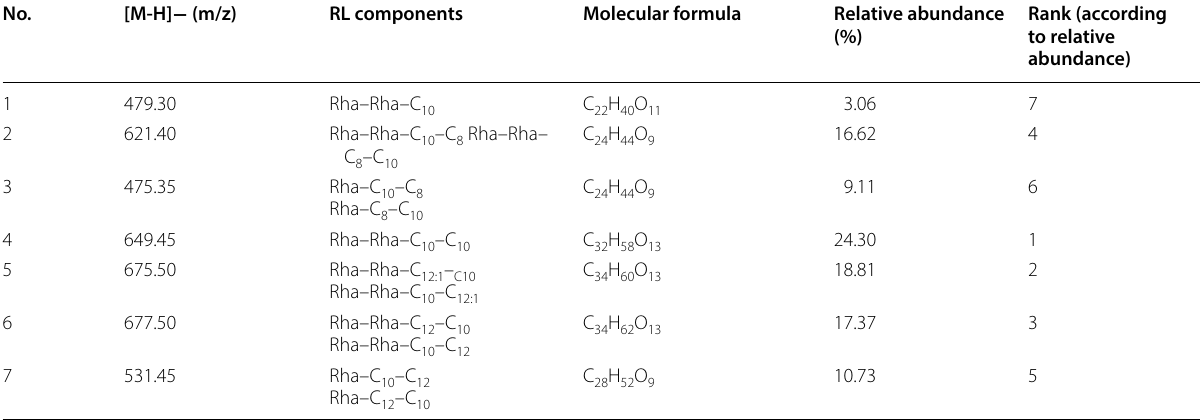
Table 2 Composition of RL Mixture produced by P. aeruginosa P6 No. [M-H] (m/z) RL components Molecular formula Relative abundance −